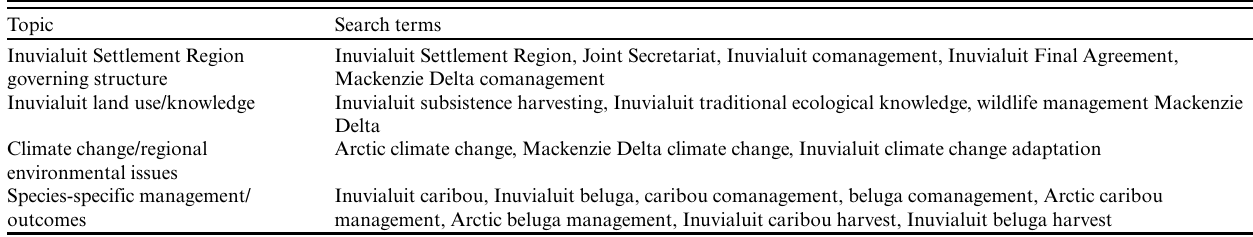
Table 2 . Key search terms used in the literature review.